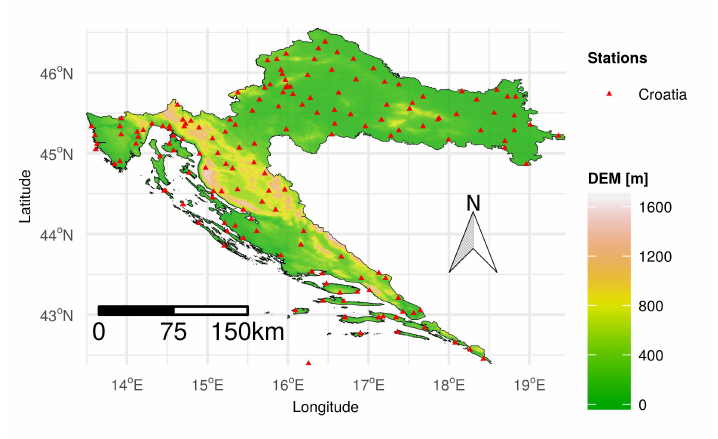
Figure 3. Station locations in Croatia on top of a digital elevation model (DEM) of the study